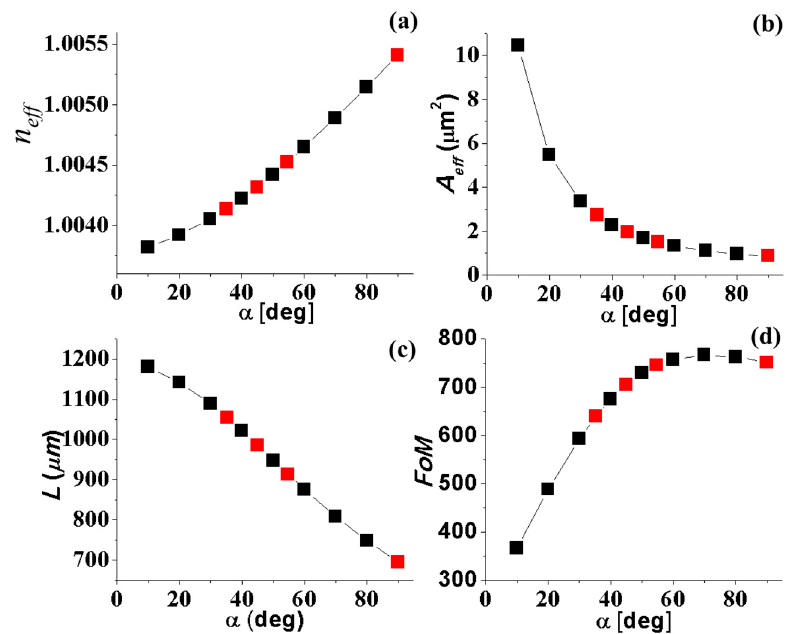
Figure 5. The propagation characteristics of the WPP mode at various sidewall corners: ( a ) effective mode index ( n eff ), ( b ) effective mode area ( A eff ), ( c ) propagation length ( L ) and ( d ) the figure of merit ( FoM ).